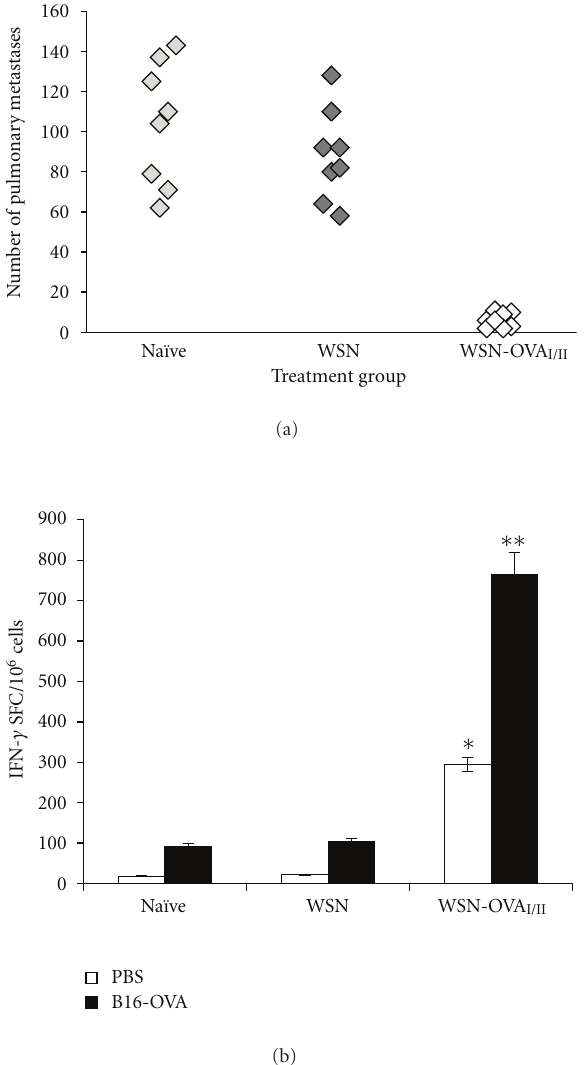
Figure 5: Protective and antigen-specific immunity to melanoma B16 cells expressing OVA. C57BL/6J mice were immunized once with either the parental WSN virus or the recombinant WSN- OVA I / II virus. Three weeks after immunization, mice were chal- lenged i.v. with 3 × 10 5 B16-OVA cells or with PBS. The number of pulmonary metastases (a) and the frequency of SIINFEKL-specific IFN- γ -producing T cells, as measured by using the ELISPOT assay on spleen-derived lymphocytes (b) was determined 12 days after the tumor cell inoculation. All of the experiments included 8 mice per group and were repeated three times with similar results. ∗ P < 0 . 001 and ∗∗ P < 0 . 0001, comparing WSN-OVA I / II -versus WSN-infected and na¨ıve